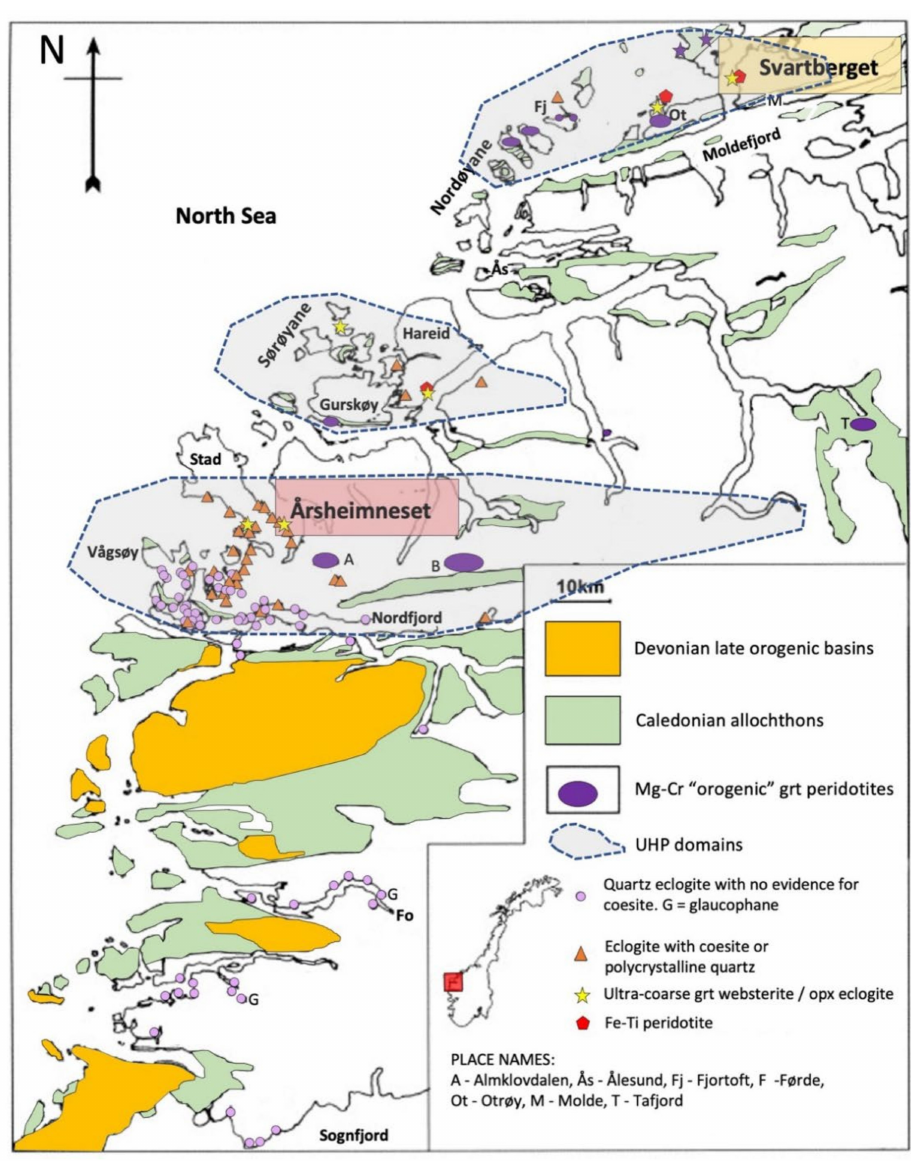
Figure 1. Map of the WGR, western Norway, redrawn after [33], showing the petrographic con- text and location of the two areas of Årsheimneset and Svartberget in this study. UHP domains modified from